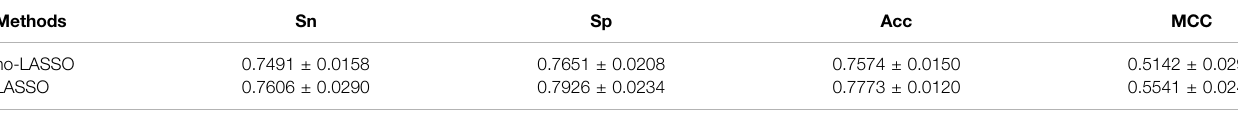
TABLE 4 | Effectiveness analysis of LASSO on the training set according to ten-fold cross-validation. Methods